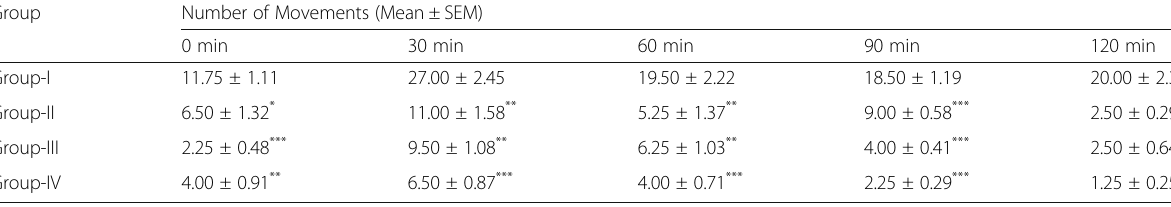
Values are represented as mean±SEM, ( n =5). Group I (control) animals received vehicle (1% Tween 80 in water), Group II (standard) received diazepam 1 mg/kg body weight, Group III and Group IV were treated with 200 and 300 mg/kg body weight (p.o.) of the methanolic extract of L. sativus L. seeds ,